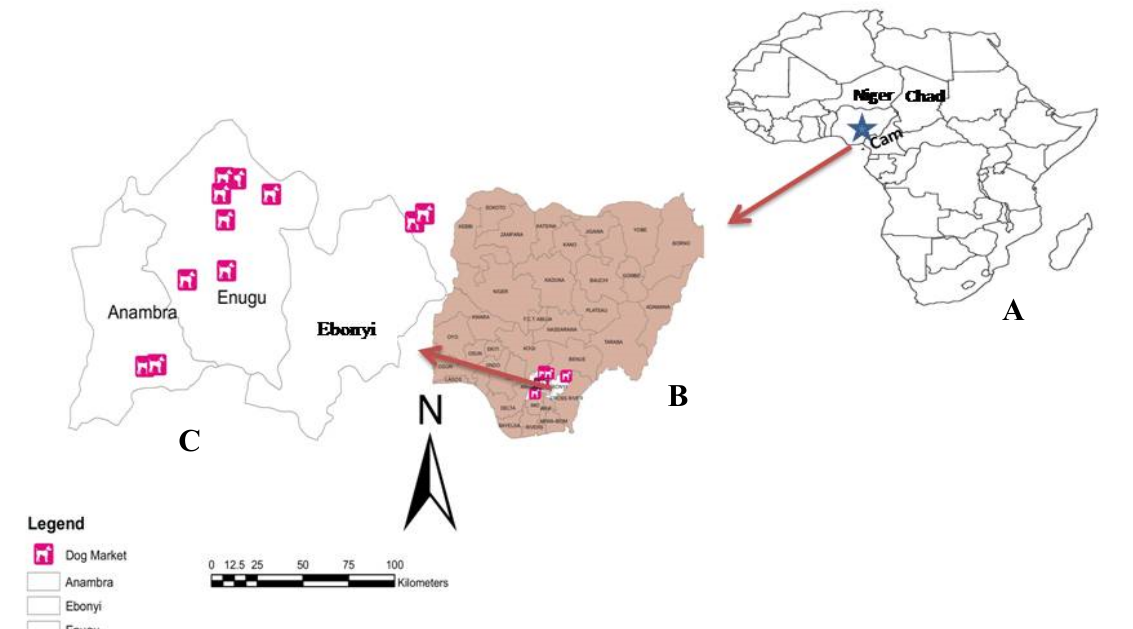
Figure 1. Map of West Africa showing Nigeria ( A ), South East region in the southeastern part of the country ( B ), and the five states of Southeastern Nigeria, showing areas of specimen collection in Anambra, Ebonyi, and Enugu States ( C